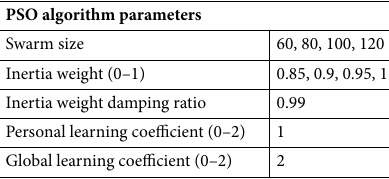
Table 1. Particle swarm optimization algorithm parameters.